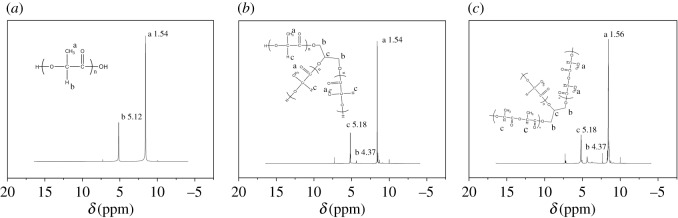
1H-NMR spectra of linear PLA (a), 3-arm PLA (b) and high branching PLA (c).